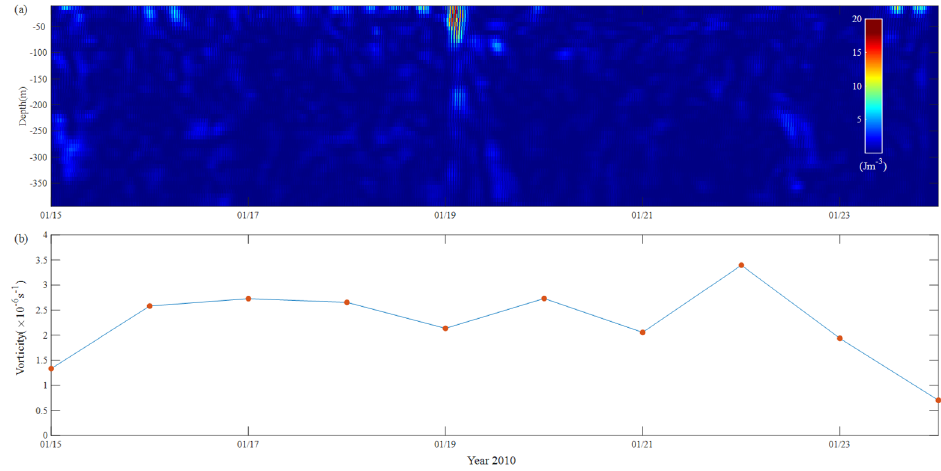
Figure 15. ( a ) Depth-time map of NIKE calculated from the undecomposed near-inertial currents in January 2010; ( b ) background vorticity at the mooring site during the corresponding observation period.